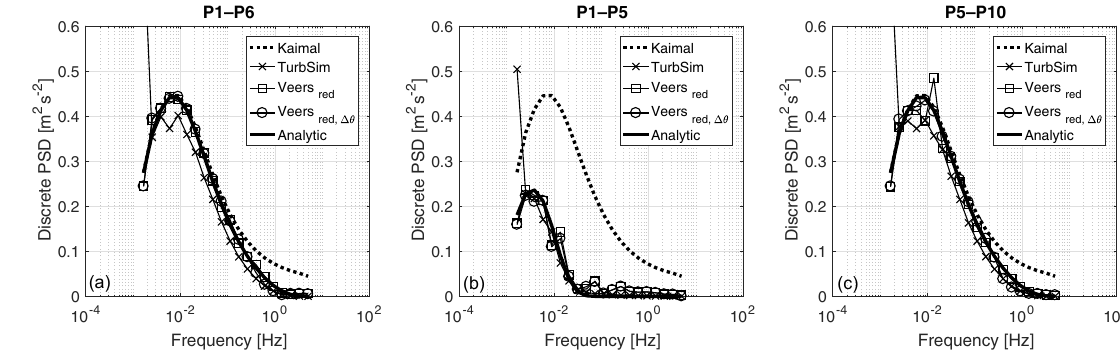
Figure 9. Wind speed cross power spectral density for three point pairs from different models, together with the analytic results (Eq. 9) and the prescribed Kaimal auto-spectrum. (a) The base point and its closest neighbor. (b) The base point and a point far away. (c) A point pair close together but far away from base point.